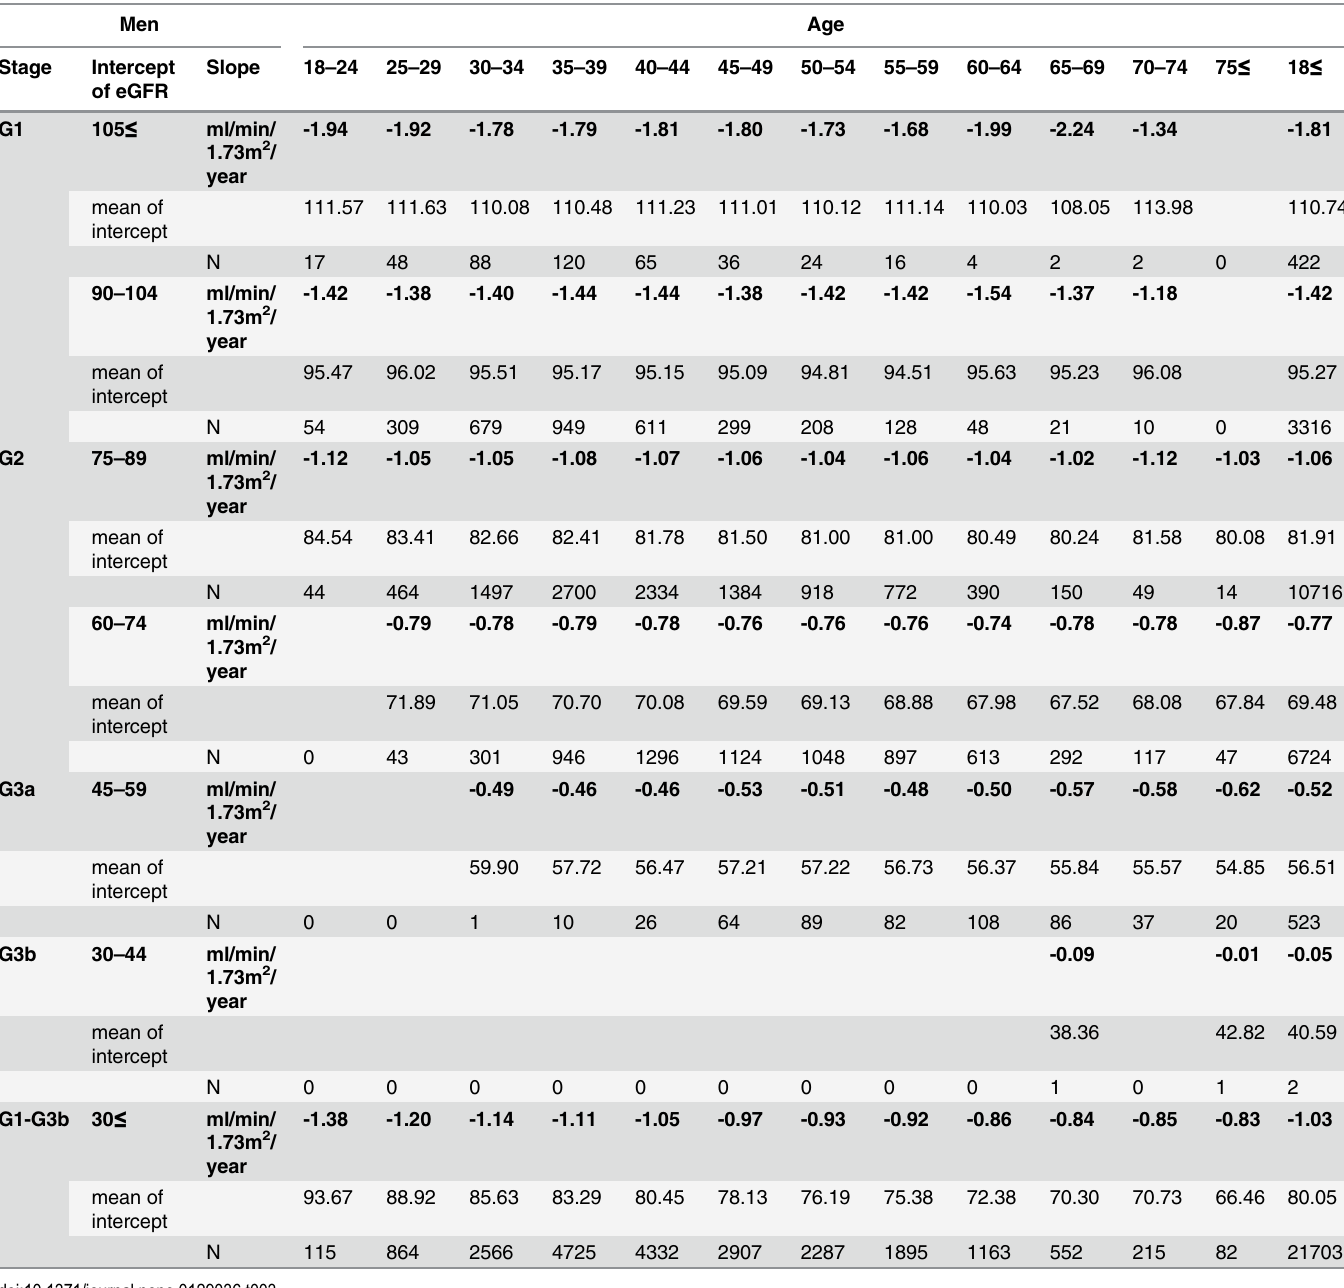
Table 3. Slope (ml/min/1.73m 2 /year) of eGFR decline in healthy